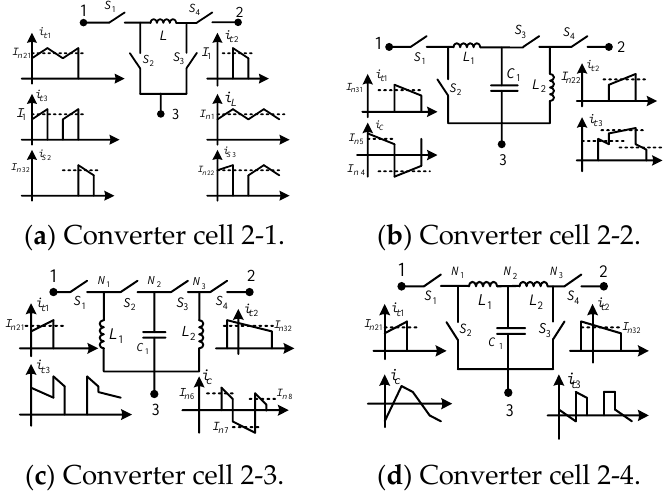
Figure 2. Converter cells that generate pulsed current signals at all three terminals.